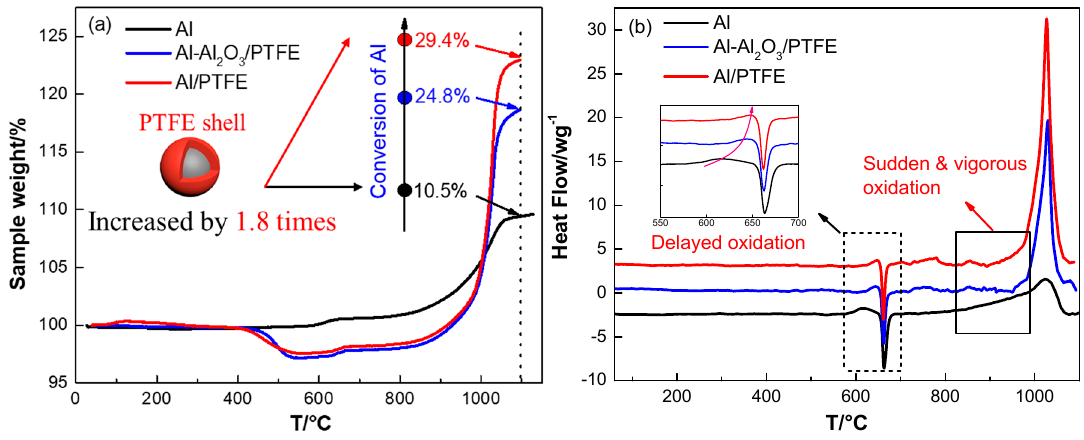
Figure 7. TGA/DSC curves of pure Al, Al-Al 2 O 3 /PTFE and Al/PTFE in air atmosphere, ( a ) TGA; ( b ) Differential scanning calorimetry (DSC). The testing conditions were air atmosphere, 10 K/min.